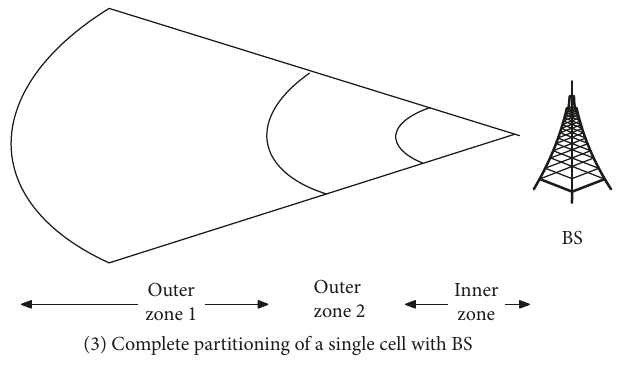
Figure 3: Creation of network partitions.